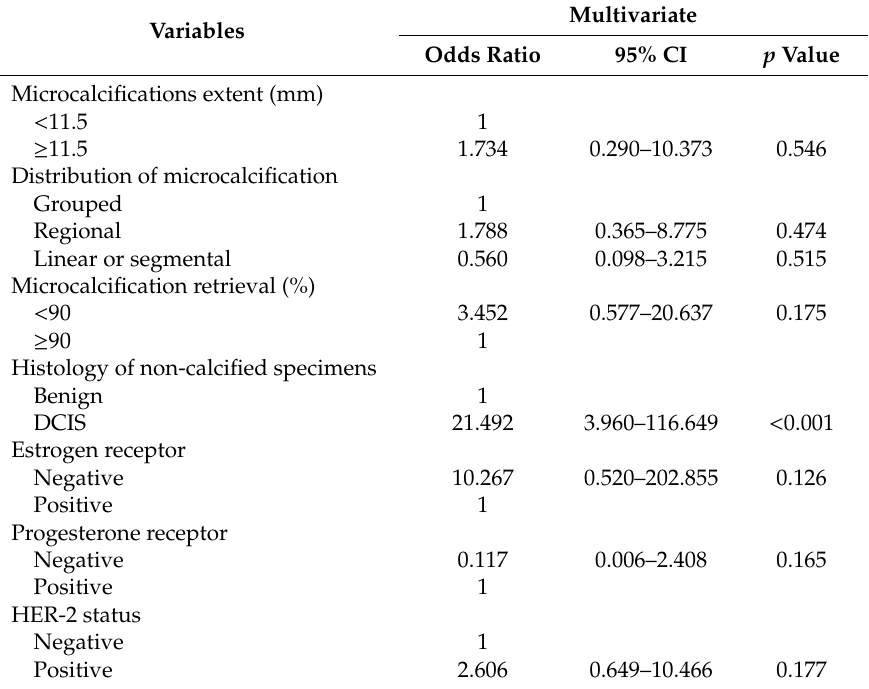
Table 3. Multivariate logistic regression in predicting DCIS